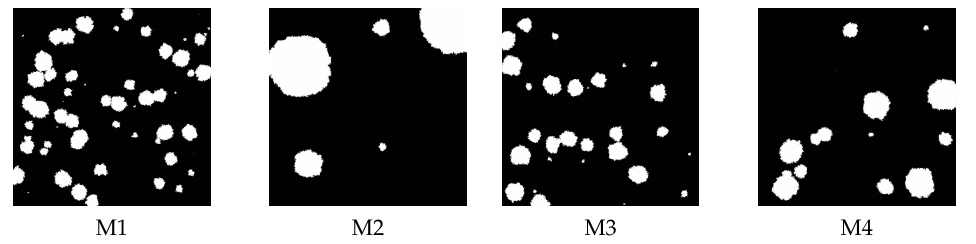
Figure 4. The artificial membrane structures with different structural parameters: M1 ( ρ = 0.85, d f = 1.9707, ∆ D = 0.3492); M2 ( ρ = 0.85, d f = 1.9672, ∆ D = 1.5094); M3 ( ρ = 0.9, d f = 1.9830, ∆ D = 0.2906); and M4 ( ρ = 0.9, d ∆ D = f = 1.9790,